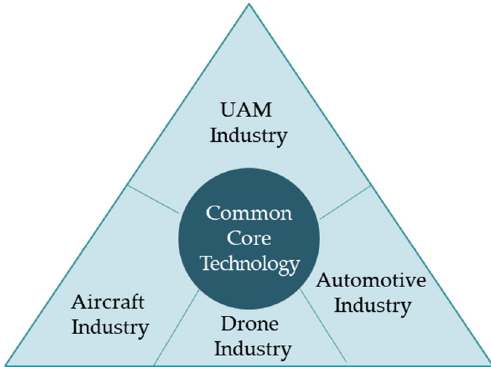
Figure 4. Global UAM ecosystem, KSAE 2021.